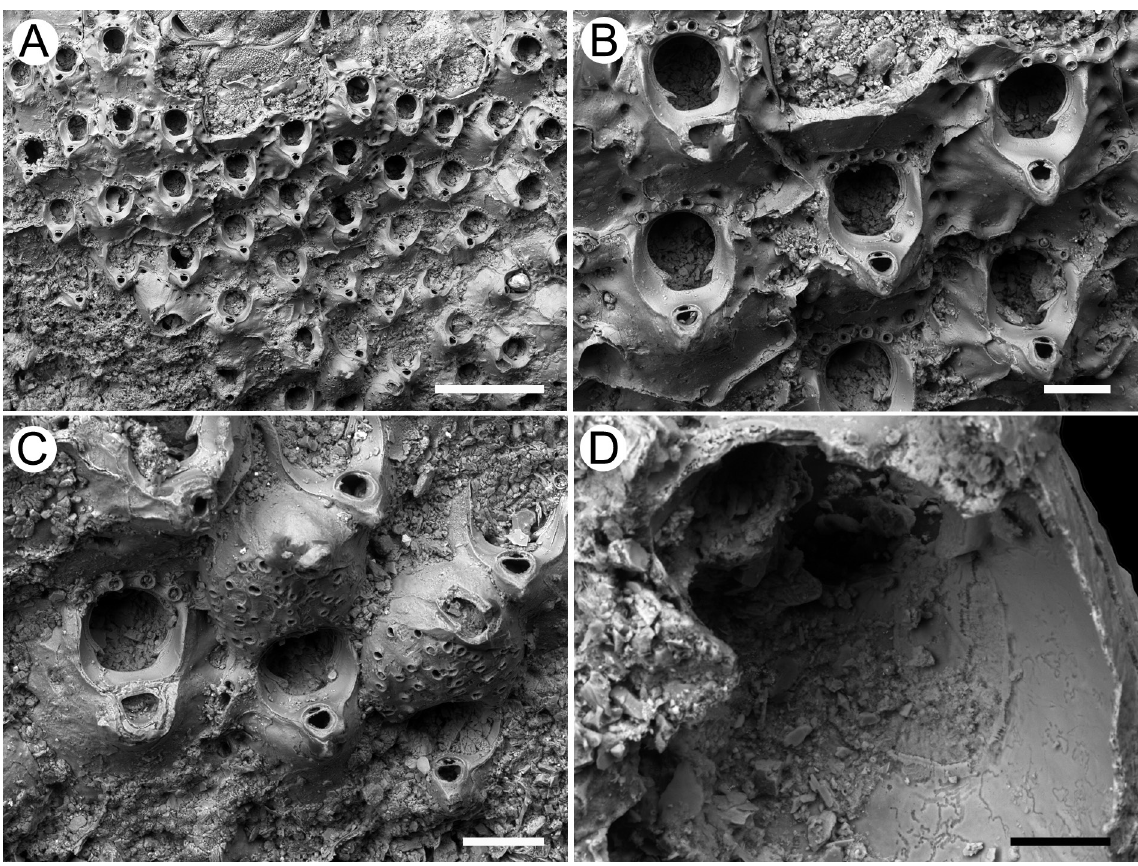
Fig. 3. Parkermavella columnaris sp. nov. A–C . Paratype (NHMUK PI BZ 7832), Castlecliffian, Pleistocene, Upper Kai-Iwi Shellbed, New Zealand. A . View of a small colony. B . Group of autozooids. C . Two ovicellate zooids. D . Paratype (NHMUK PI BZ 7833), same provenance as preceding, inner view of the frontal shield showing part of the ring scar bordering the umbonuloid area. Scale bars: A = 500 µm; B–C = 100 µm; D = 50